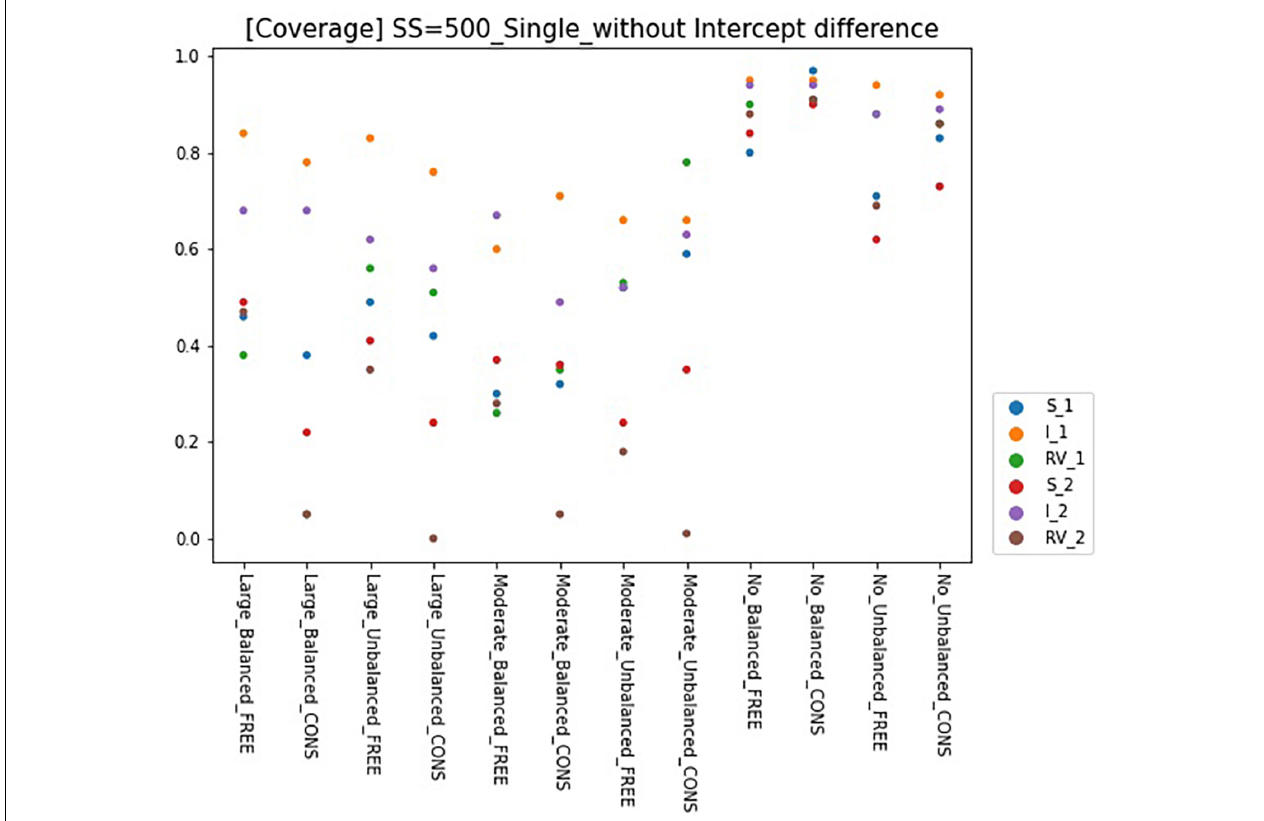
FIGURE 6 | Coverage of 95% confidence interval of single-predictor models (sample size = 500, without intercept difference). Free, residual variances freely estimated; Cons, residual variances equally constrained; SS, sample size; CP, class proportion; RV, the disparity in the magnitude of class-specific residual variances; C1_S, slope for class 1; C1_I, intercept for class 1; C1_RV, residual variance for class 1; C2_S, slope for class 2; C2_I, intercept for class 2; C2_RV, residual variance for class